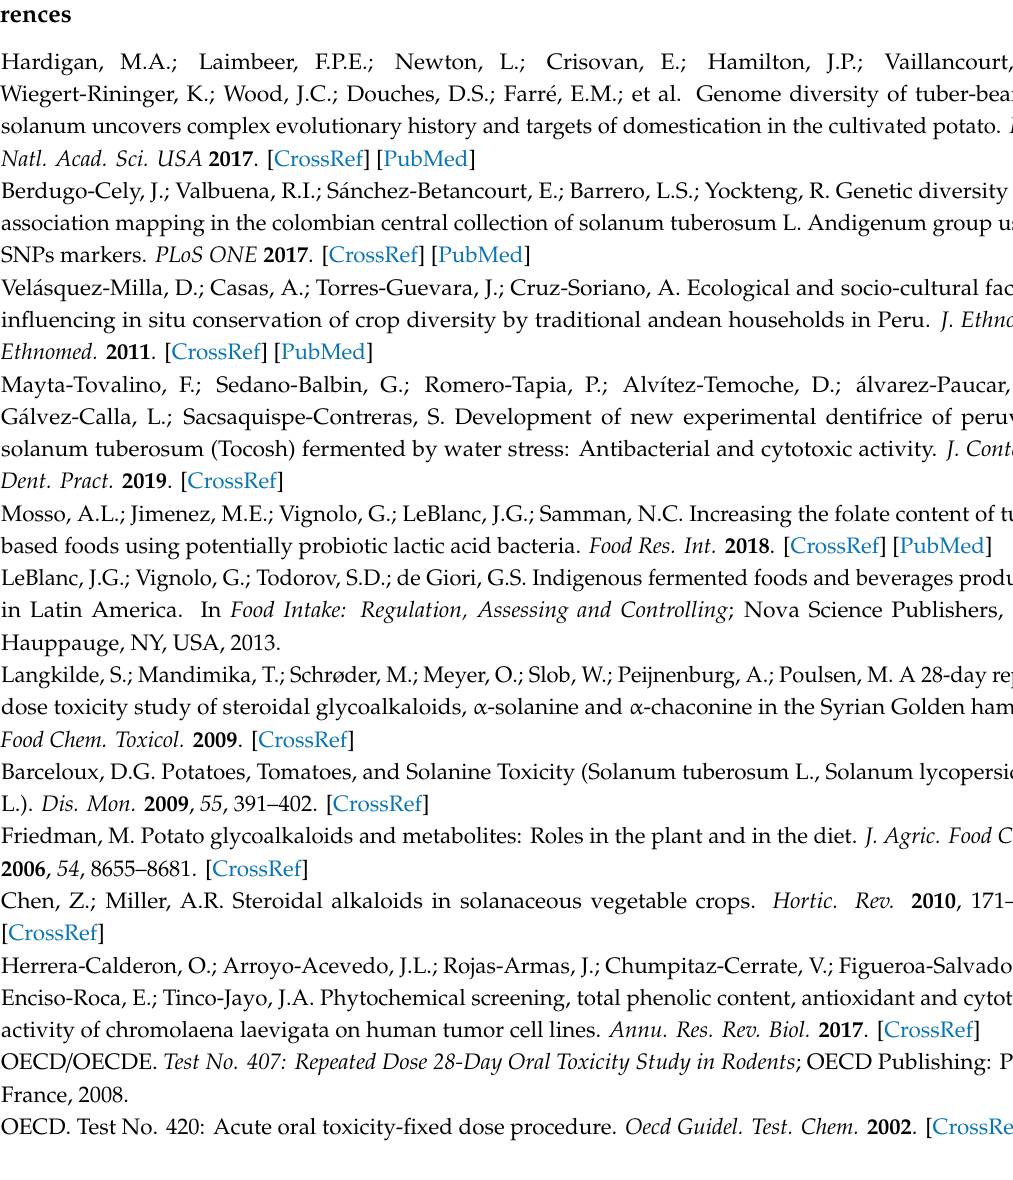
Figure S1: Images of some tissues of male and female mice without specific alterations that received fixed doses of 2000 mg / kg and 5000 mg / kg of Tocosh Flour stained with H&E and 40X, Figure S2: Images of the organ sections: Stomach (A), liver (B), Kidney (C) and heart (D), of male rats who were administered Tocosh flour for 28 days. Subscript C and 1 refer to the control group and the group administered at dose of 1000 mg / kg / day, respectively. H&E staining, 40X, Figure S3: Images of the organ sections such as: Stomach (A), liver (B), Kidney (C) and heart (D), of female rats that were administered Tocosh flour for 28 days. Subscript C and 1 refer to the control and group administered at dose of 1000 mg / kg / day, respectively. H&E staining,